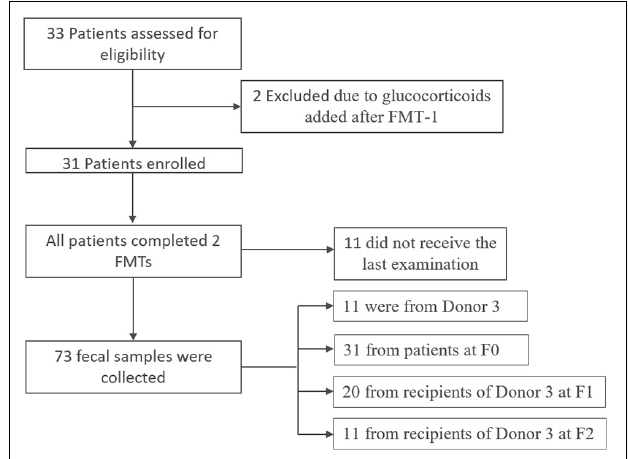
FIGURE 1 | Flow of patients in the trial.